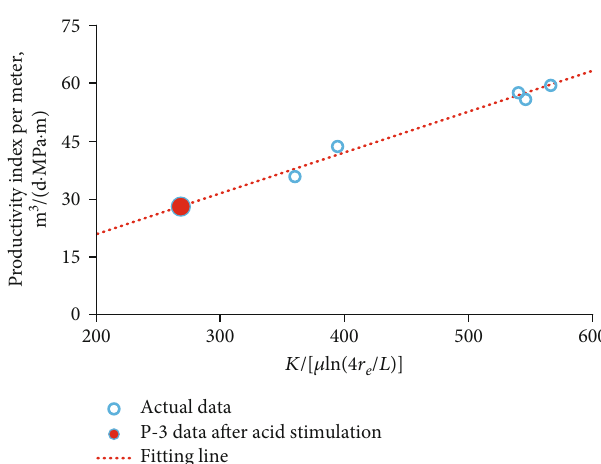
Figure 10: Productivity index per meter evaluation of P-3 after acid